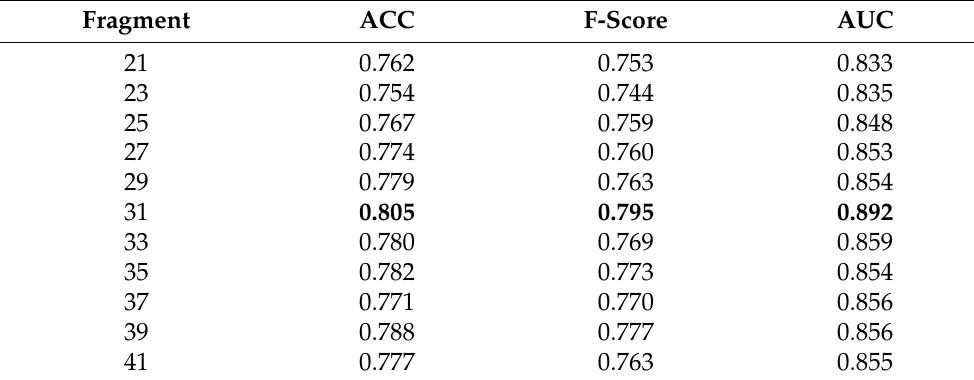
Table 3. 10-fold cross-validation result on different fragment lengths.